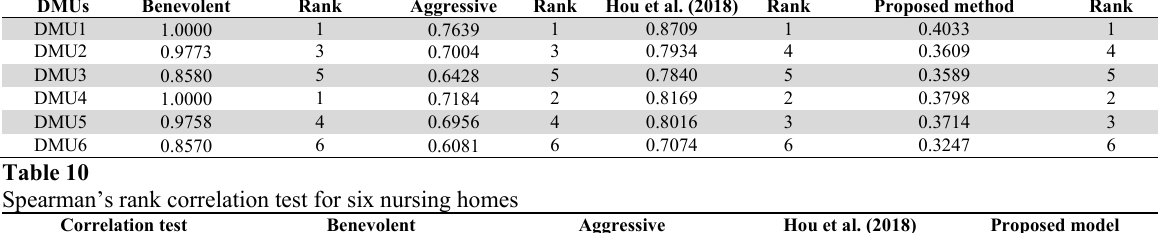
The ranking of each DMU for six nursing homes DMUs